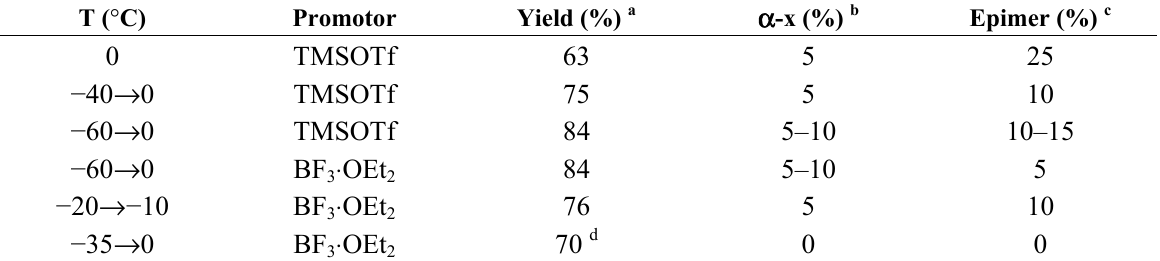
Table 1. Conditions for the gentiobiosylation of 1,2- O -isopropylidene